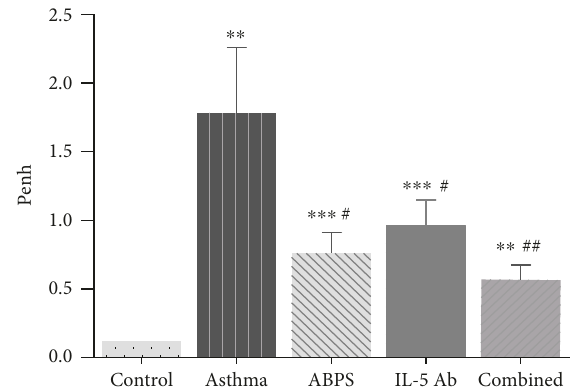
Figure 2: E ff ect of anti-IL-5 mAb and ABPS treatment on hyperresponsiveness induced by methacholine. Airway response of control, asthma group, or therapy group to methacholine (24 h after exposure to HDM). Data was presented as mean Penh +SEM and was from one experiment, with n = 10 mice per group. ∗∗ P < 0 01 , ∗∗∗ P < 0 001 , compared to the control group. # P < 0 05 , ## P < 0 01 , compared to the asthma group. The signi fi cance of the data was evaluated by one-way ANOVA with Bonferroni ’ s multiple comparison test compared to